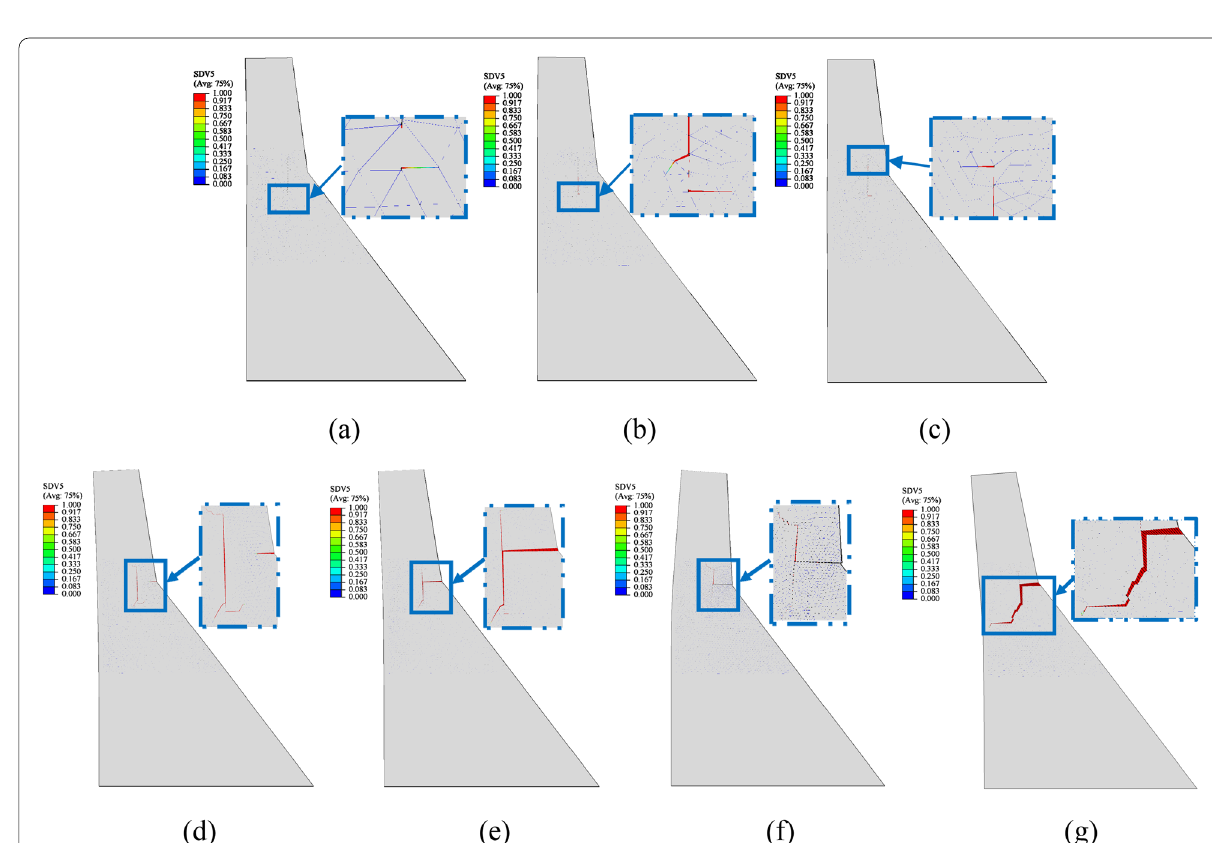
2 s, b t 2.36 s, c t 2.4 s, d t 2.62 s, e = = = =